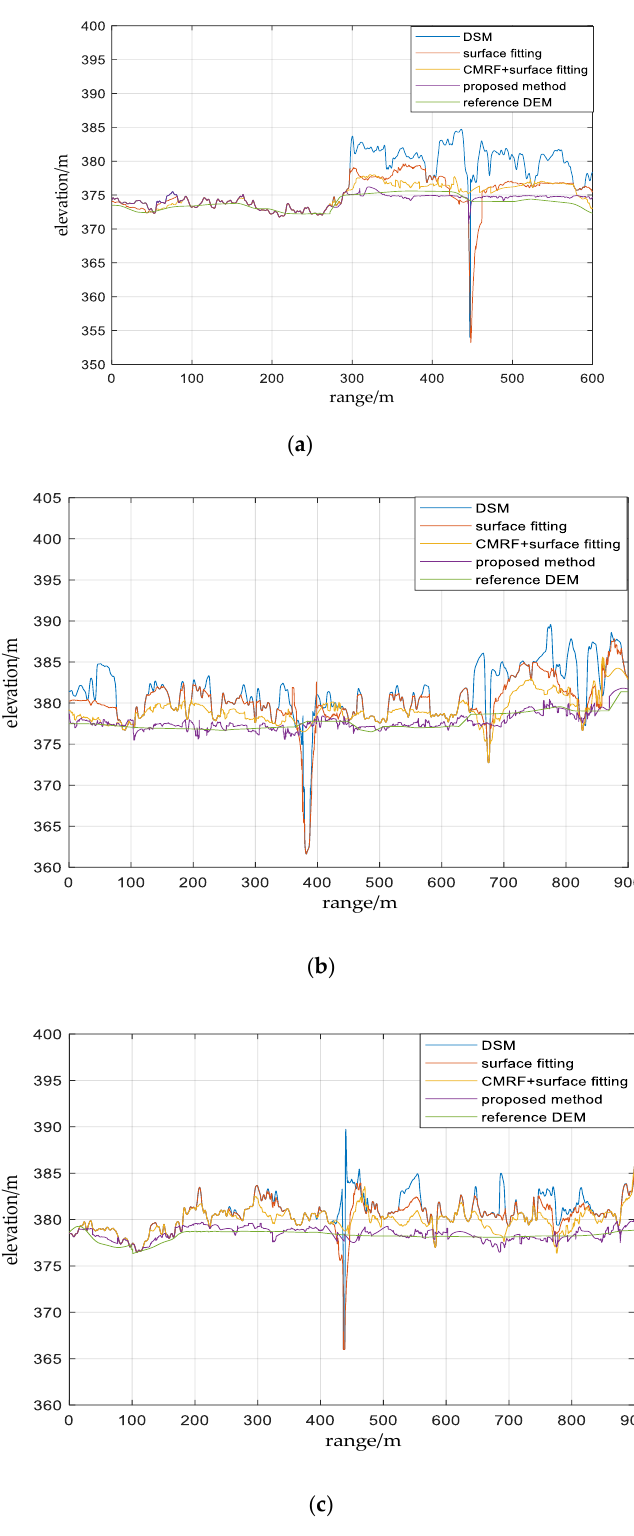
Figure 11. Altimetric profile comparison between the DSM, the reconstructed DEM based on different methods, and the reference DEM, where ( a – c ) are the altimetric profiles of experimental results corresponding to Site A – C. The profile position is at the red dashed line in Figure 10g – i.